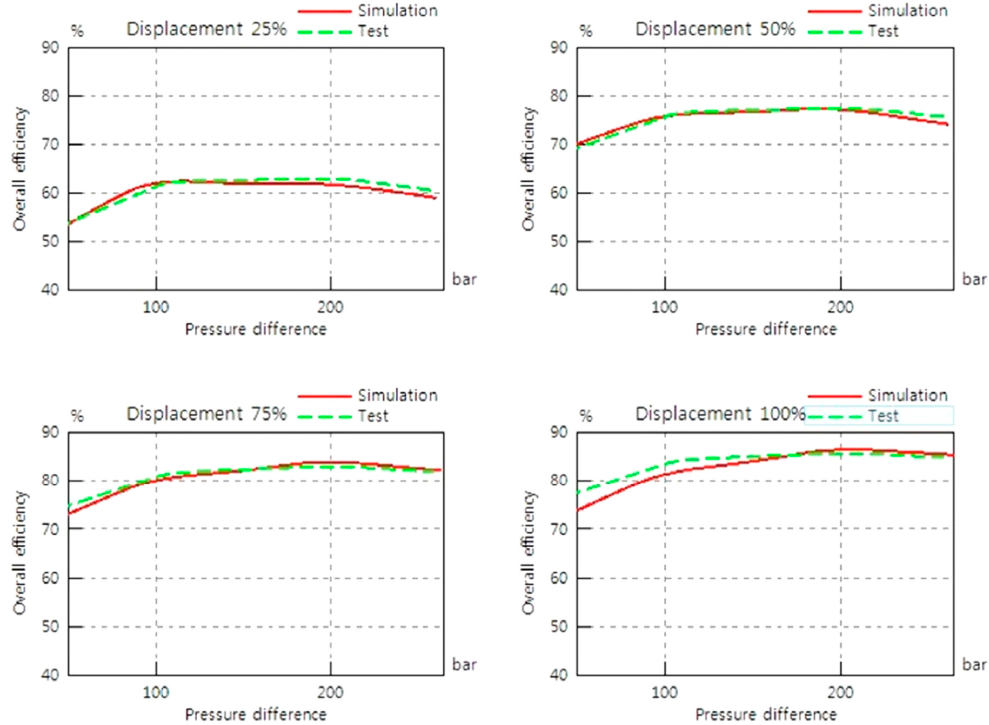
Figure 5. Results of the simulation and test of the hydraulic motor.